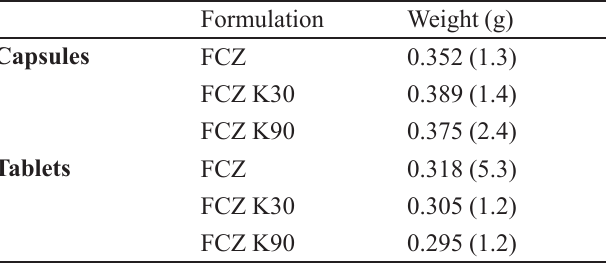
TABLE III - Average weight data of capsules and tablets produced with fluconazole (FCZ) and granules (FCZ K30 and FCZ K90).